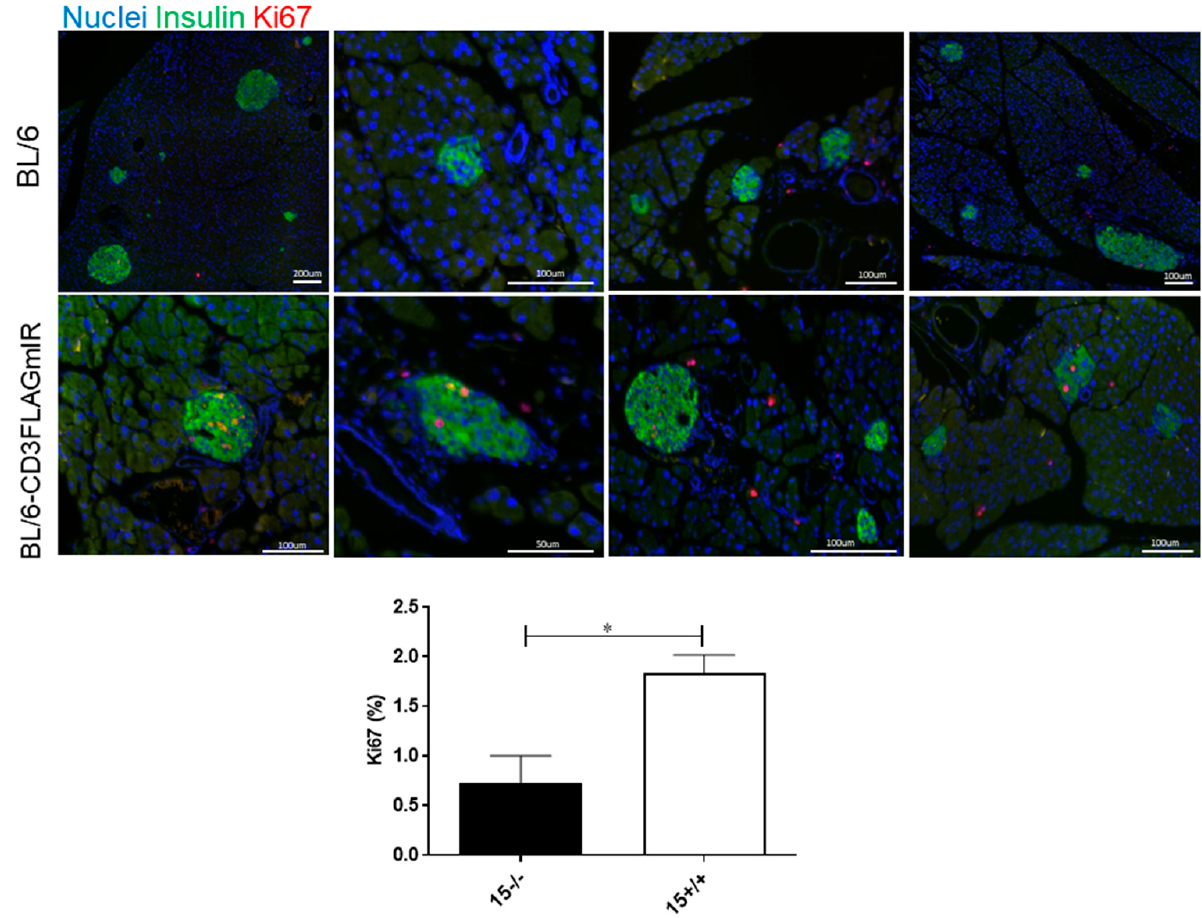
Figure 10. Immunofluorescence labelling of pancreatic tissue sections from 15-week-old mice representing Insulin + Ki67 + beta cells in the islet of the transgenic mice. Quantitative analysis indicates the percentage of Ki67 + cells based on Ki67 labelling of 15-week-old BL/6 and BL/6-CD3FLAGmIR pancreatic tissue ( n = 3 mice, n = 23 islets analyzed per mouse). -/- indicates BL/6 mice and +/+ indicates BL/6-CD3FLAGmIR mice. Unpaired student t test: * p ≤ 0.05.